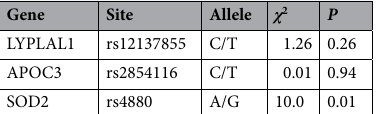
Table 4. The Hardy–Weinberg equilibrium test for the control